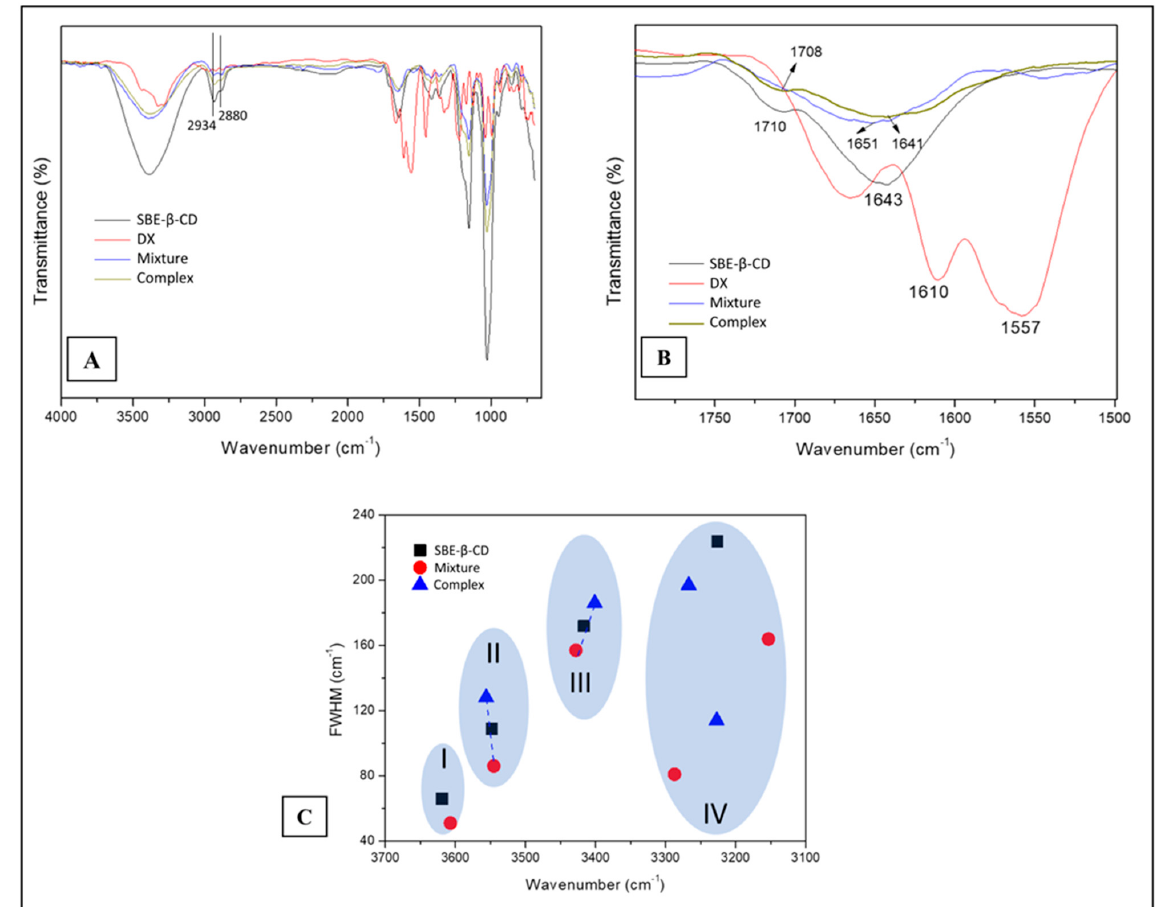
Figure 3. Infrared spectra from 4000 to 650 cm − 1 ( A ) and 1800 to 1500 cm − 1 ( B ) of samples of doxycycline (DX), sulfobutylether- β -cyclodextrin (SBE- β -CD), physical mixture, and freeze-dried complex (1:4 molar ratio). ( C ) Full width at half medium (FWHM) as a function of wavenumber in the range of 3700–3100 cm − 1 of the samples. The shadow area is related to regions (I, II, III, IV) with a maximum wavenumber.